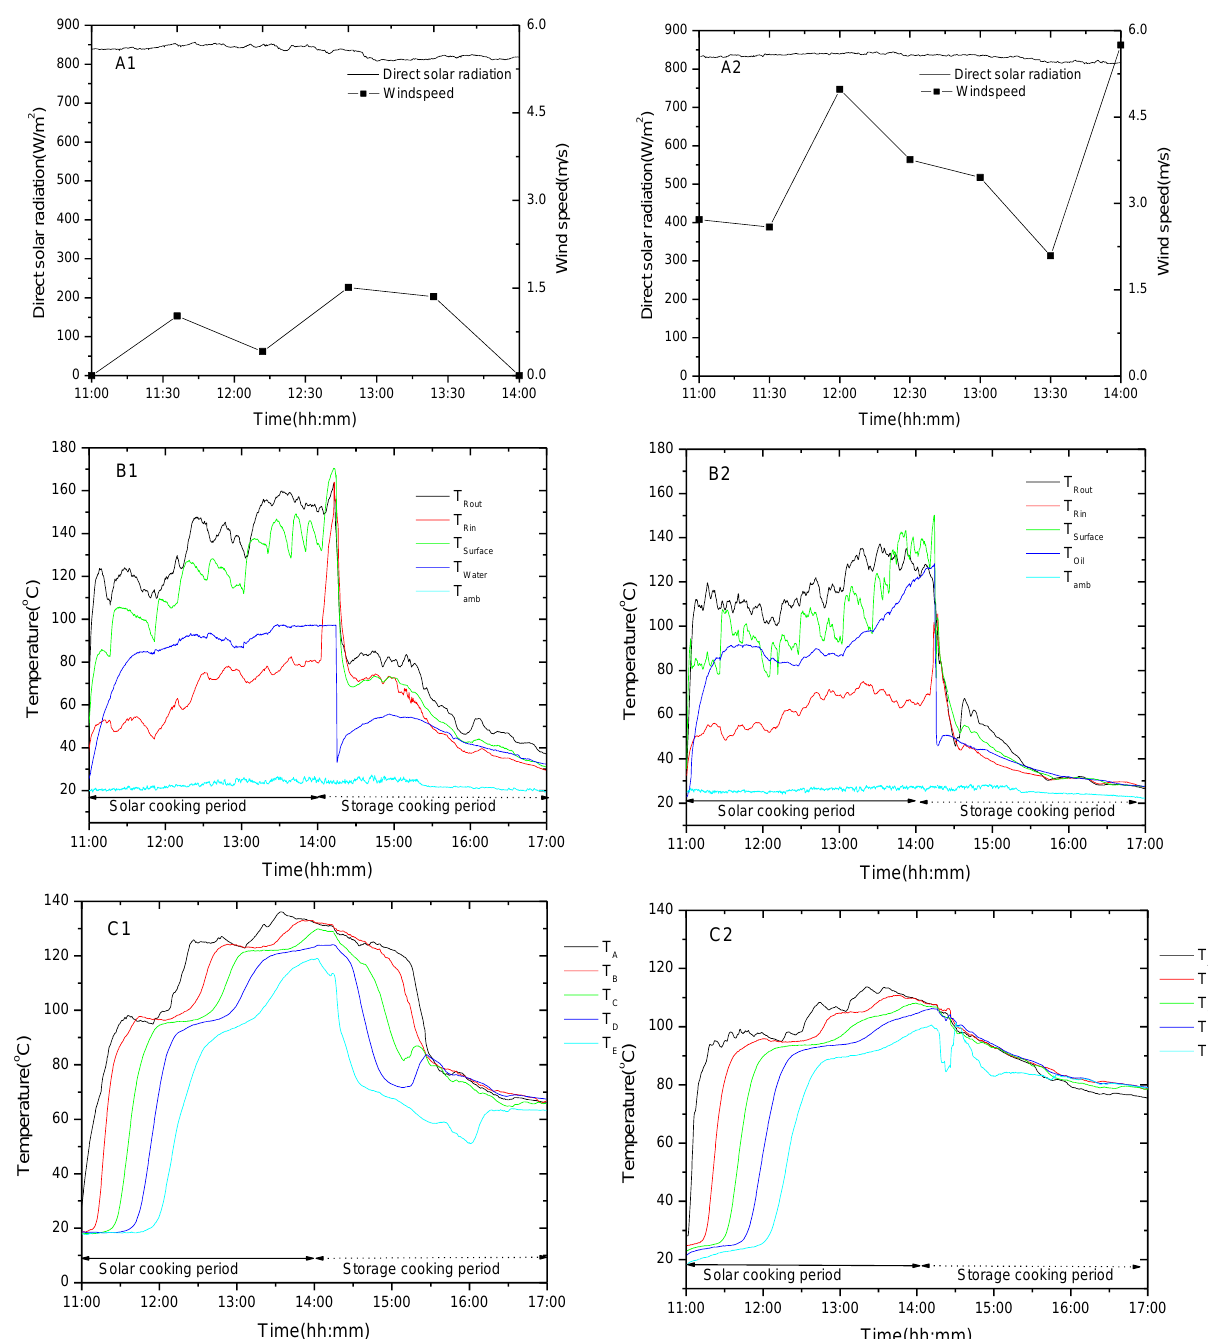
Figure 4. Experimental results of two test loads (water and sunflower oil) for a load of 0.5 kg utilizing a flow rate of 4.0 mL/s. ( A ) Direct solar radiation and wind speed ( A1 — water, A2 — sunflower oil), ( B ) the temperature profiles of the solar receiver ( B1 — water, B2 — sunflower oil), and ( C ) the temperature profiles of a storage tank ( C1 — water, C2 — sunflower oil). Experimental dates were 3 July 2021 and 4 July 2021 for water and oil tests, respectively.